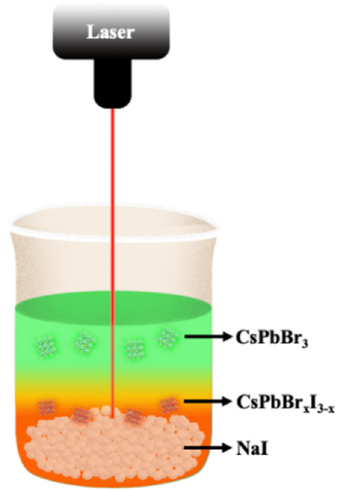
Figure 4. Experimental sketch for the halogen exchange on the solid/liquid interface.